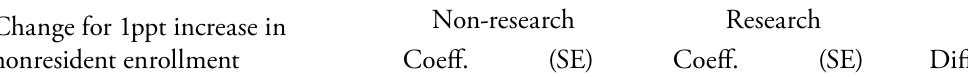
Table 5: Regressions between the percentage of nonresident students and college finances by research university